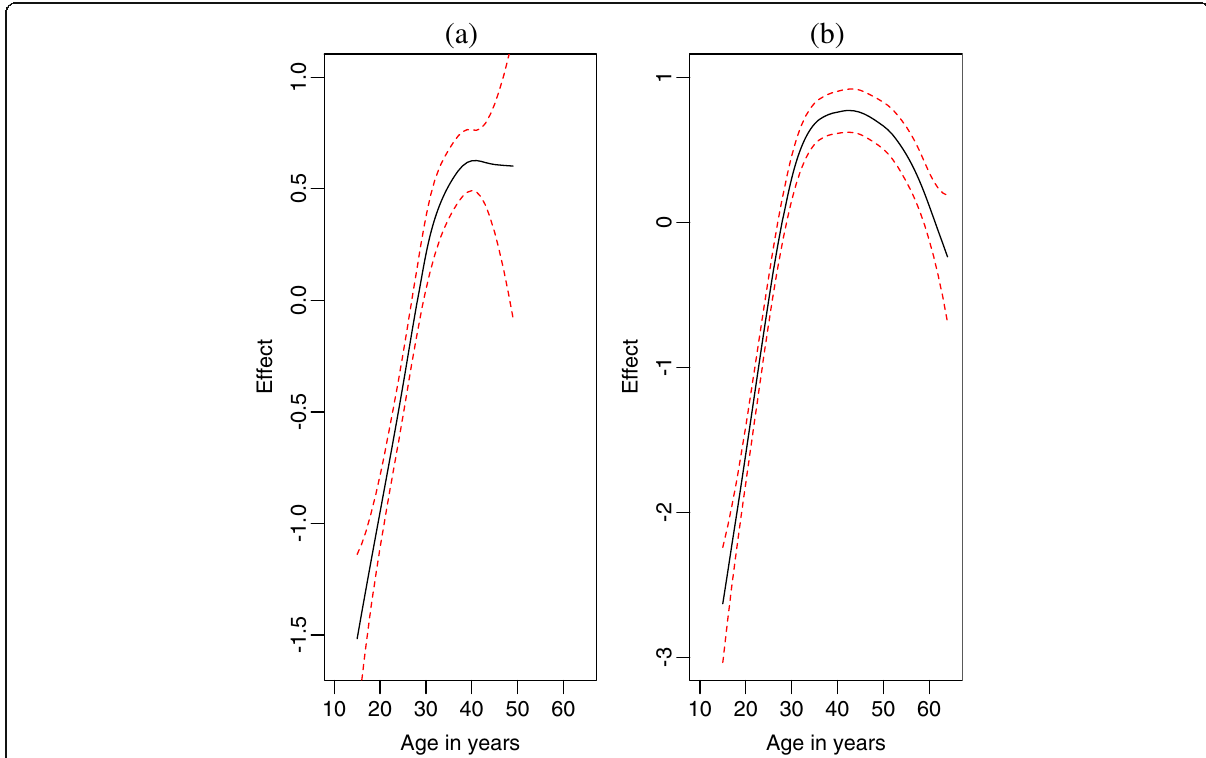
Fig. 5 Estimated nonlinear effects of age on HIV infection and corresponding 95% credible intervals: ( a ) NHSS data; ( b ) NDHS